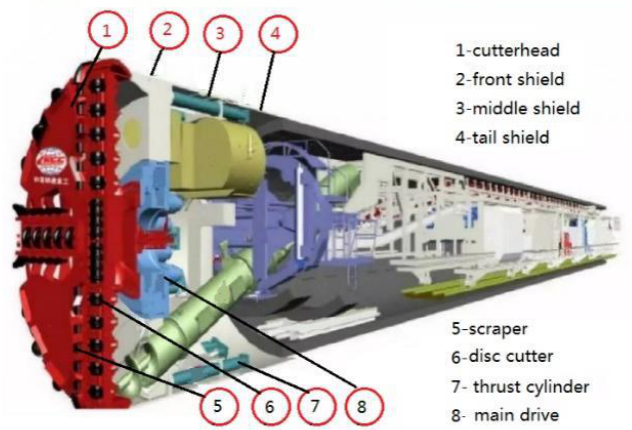
Figure 1. Structure of shield machine.